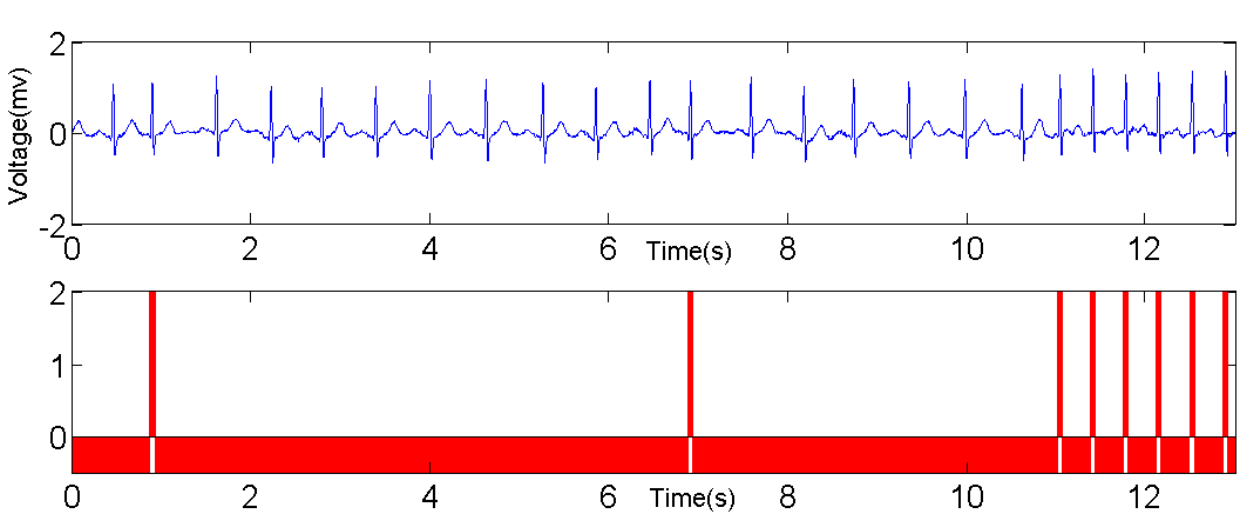
Figure 20. APC detection based on the proposed